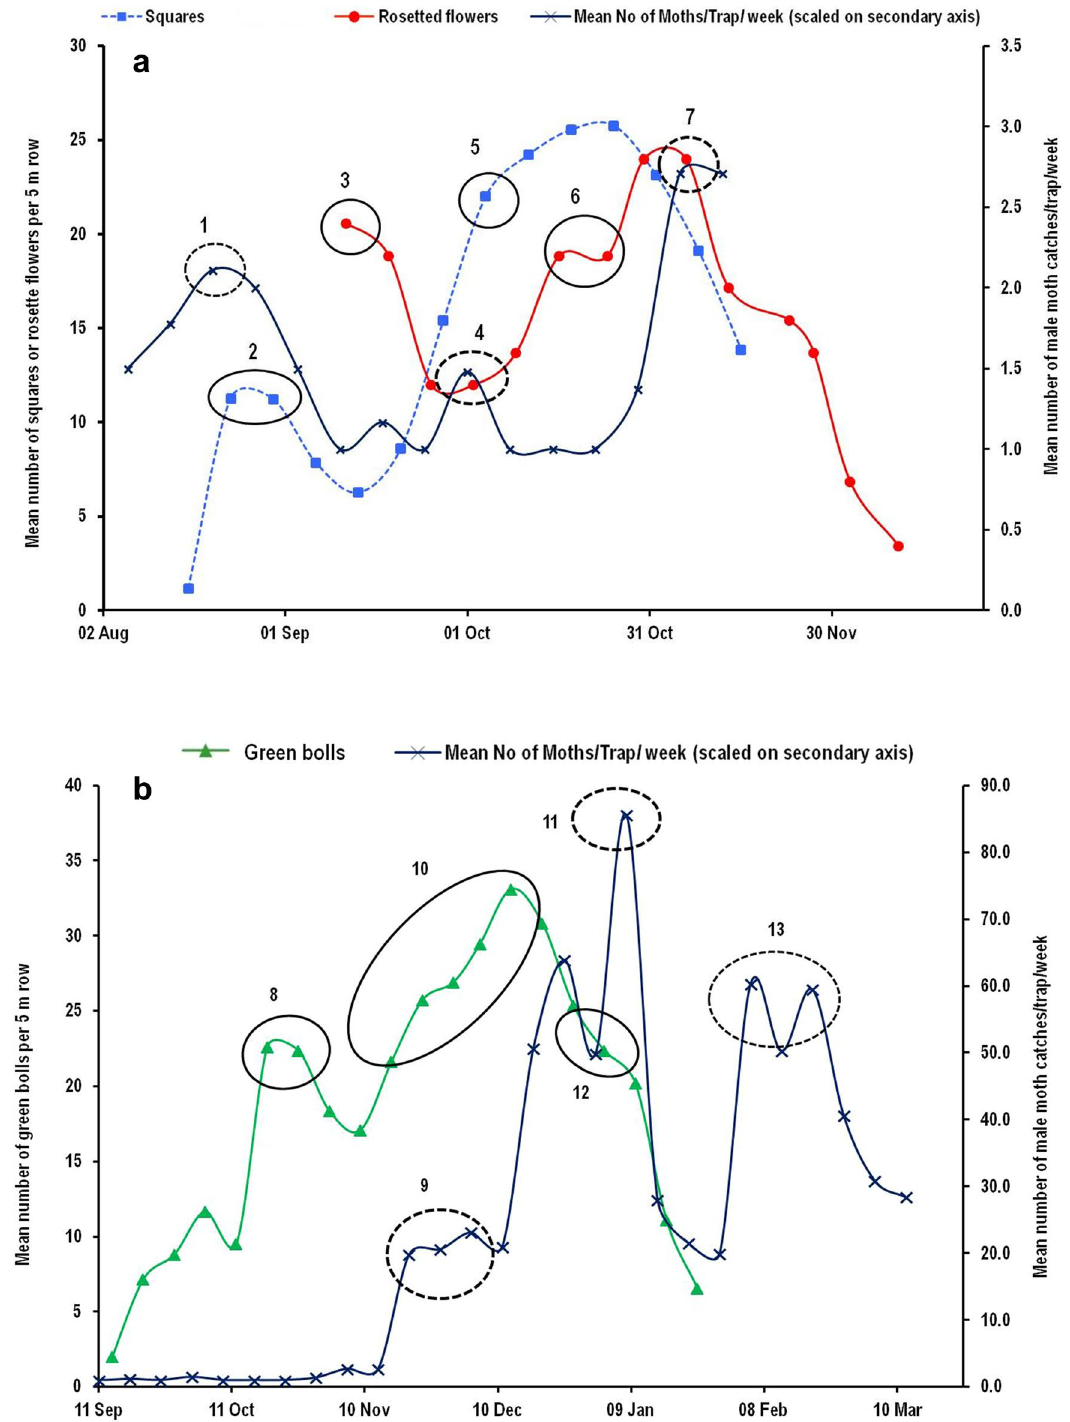
Figure 3. Validation of generation events of pink bollworm during the cotton season 2019–20. Till November 10, moth catches were very low (< 3 moths per trap per week) and pink bollworm could complete two in-field generations as indicated in dotted circle nos. 4 and 7 ( a ); whereas with ample availability of green bolls, the pest’s preference shifts from flowers to bolls giving rise to three in-field generations as indicated by dotted circle nos. 9, 11 and 13 ( b